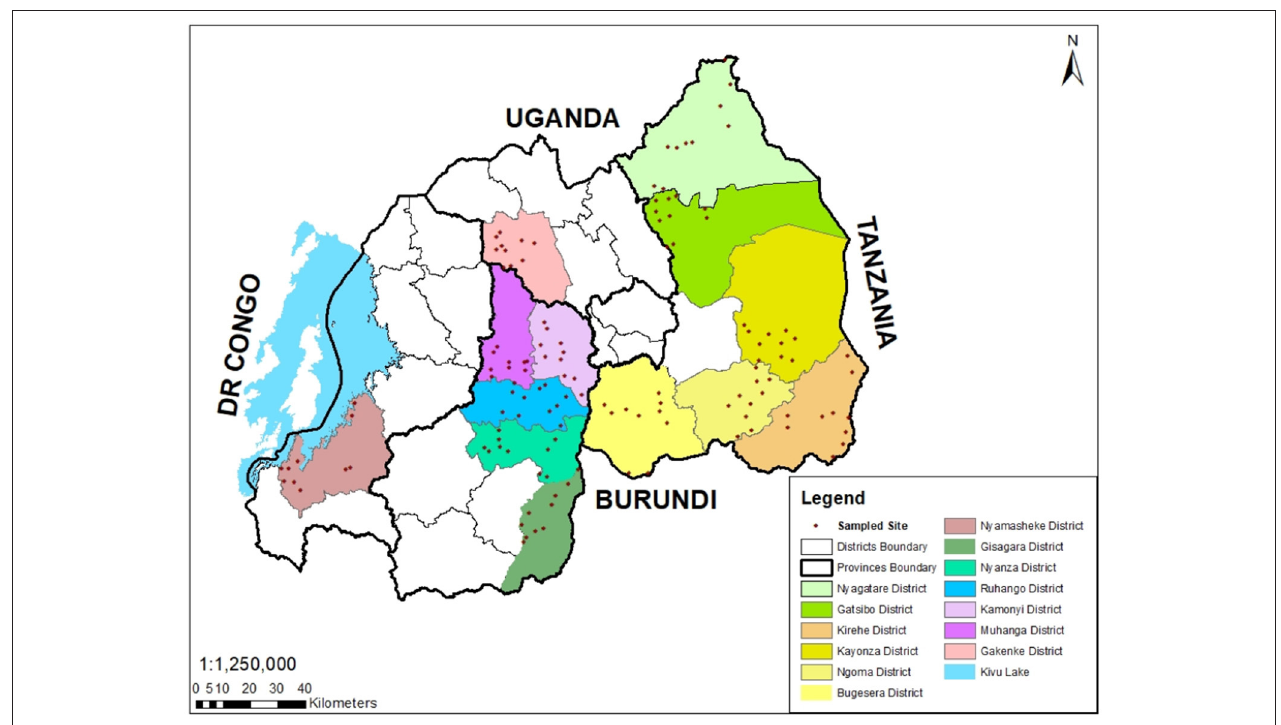
FIGURE 1 | Map of Rwanda showing surveyed districts. The red dots represent the location of the cassava fields assessed in the